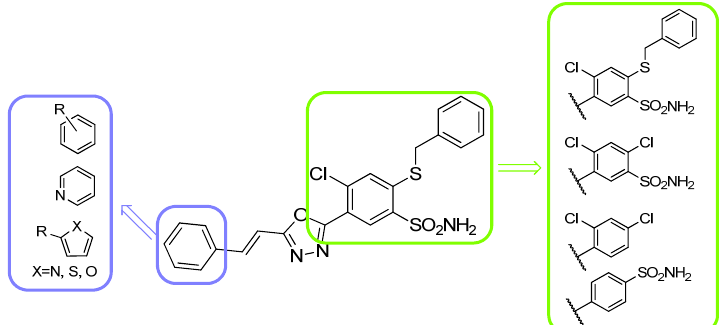
Figure 2. Hit compound and modification directions of the aryl ring (blue frame) and the sulfonamide scaffold (green frame).